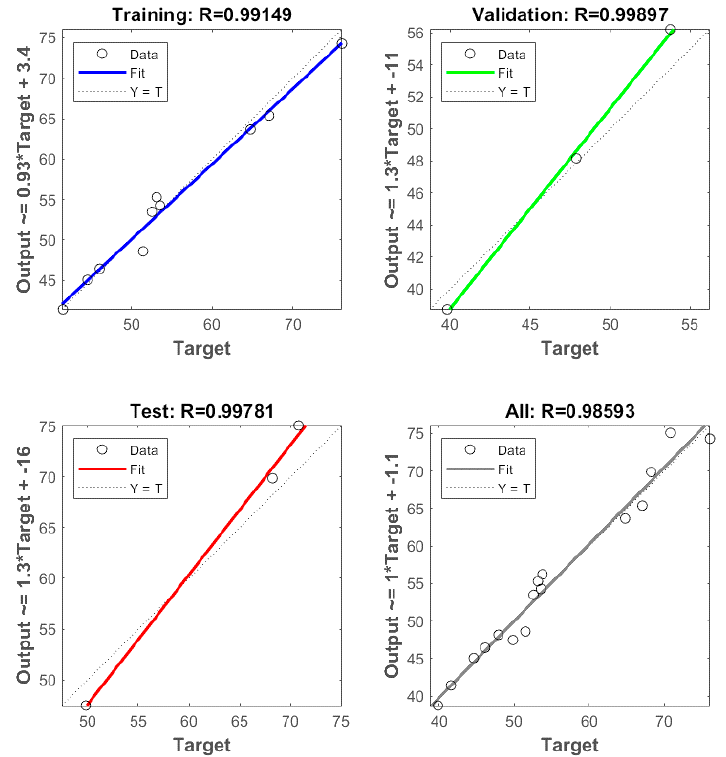
Figure 9. Coefficient of correlation (R) values of training, validation, testing and overall datasets, for elongation at break.